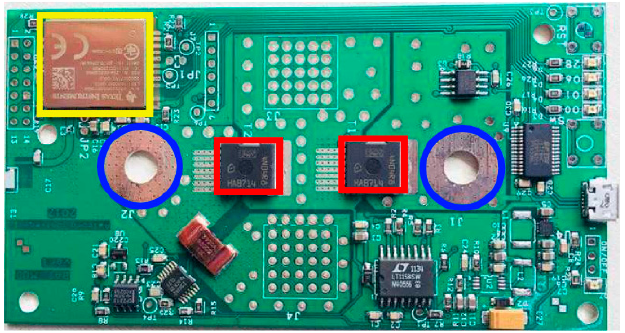
Figure 12. Slave PCB board.